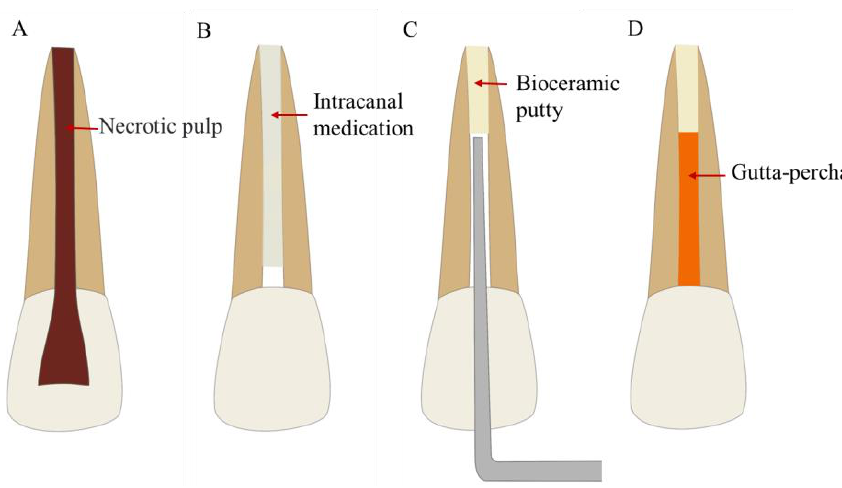
Figure 3. Treatment procedures for the apical barrier technique. ( A ) Permanent teeth with incompletely developed apical foramen and pulp necrosis or periapical disease. ( B ) Root canal disinfection. ( C ) Apical barrier using bioceramic putty. ( D ) Root canal filling.